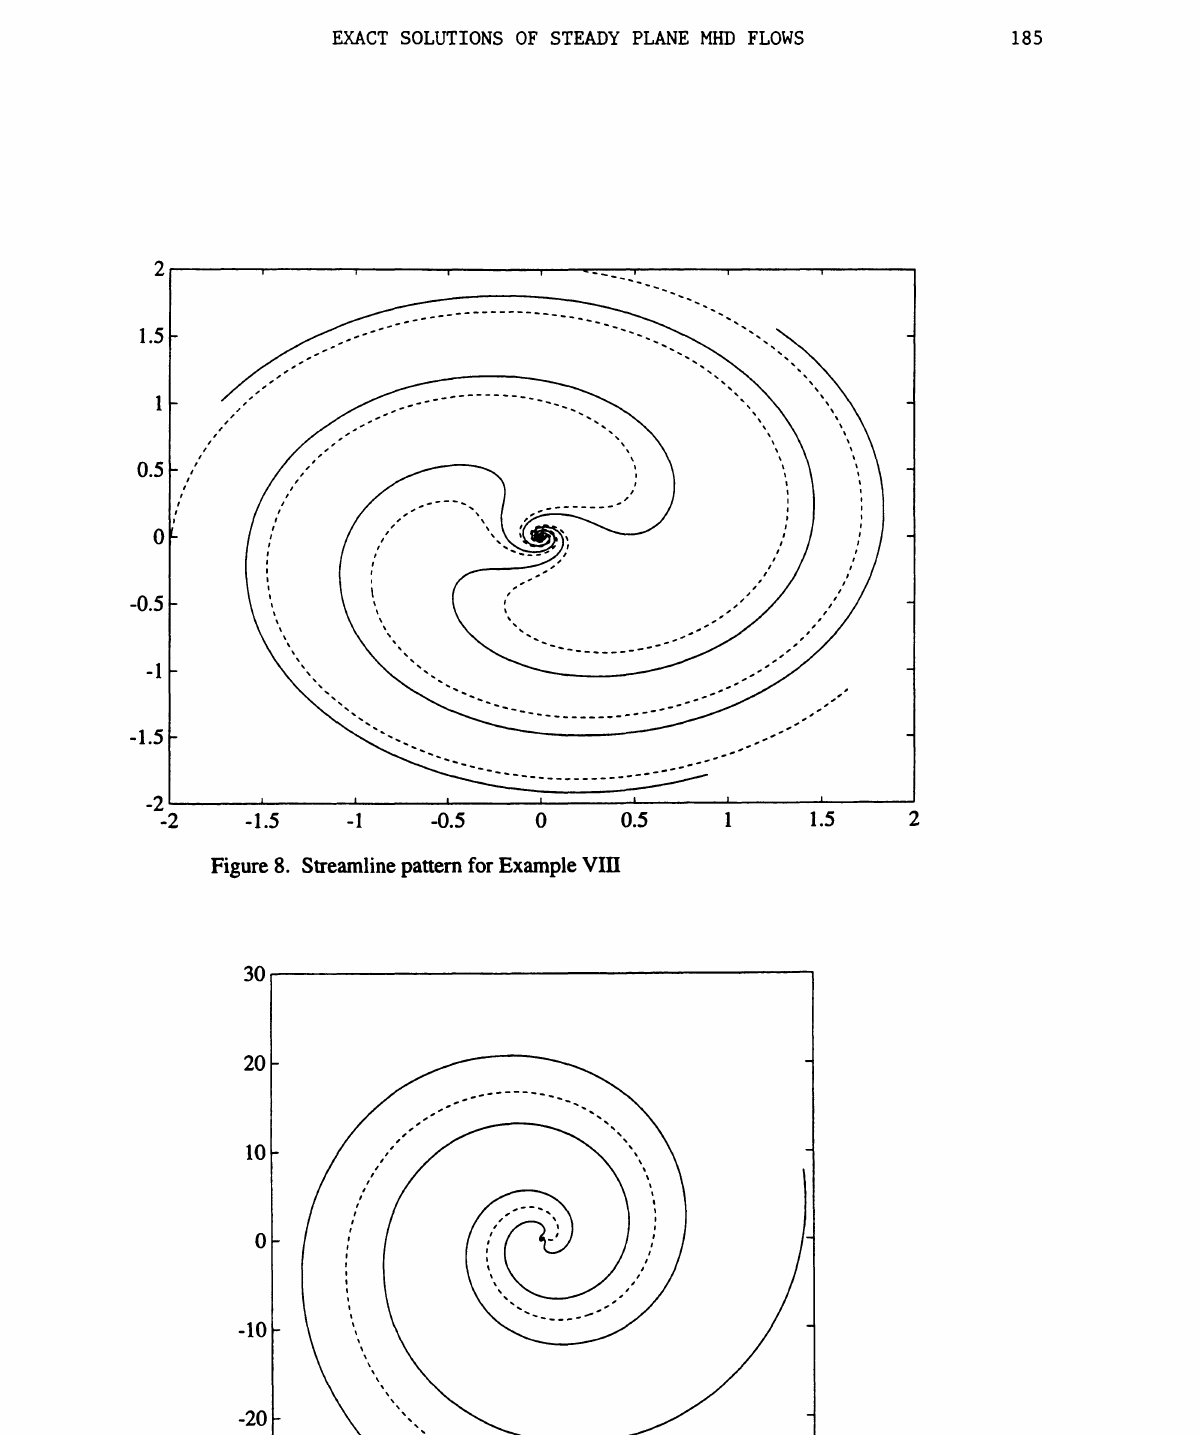
Figure 9. Streamline pattern for Example